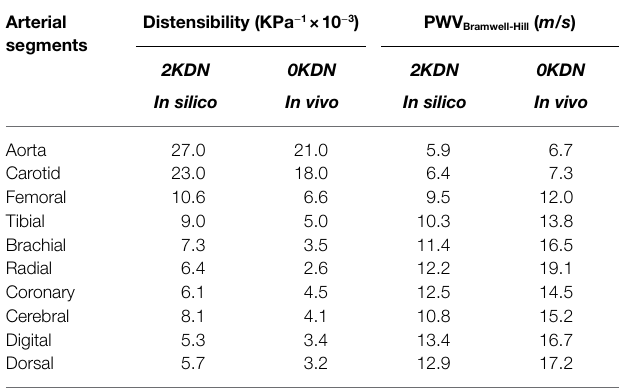
TABLE 1 | Cardiovascular parameters of the default-model configuration (2KDN). Parameter 2KDN ( In silico )